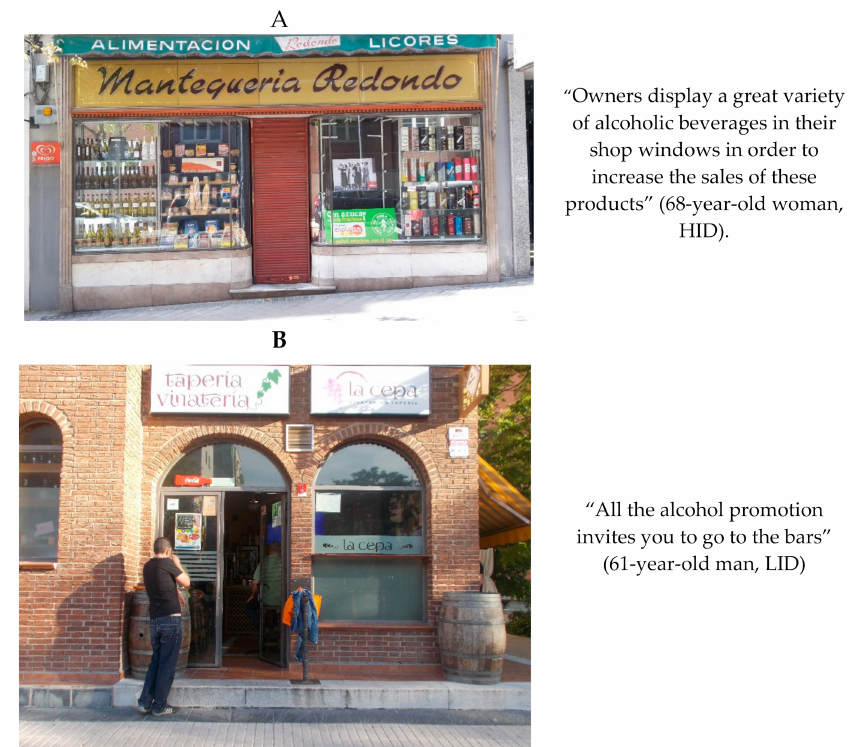
Figure 4. ( A ) Alcohol promotion perceived in high income level neighborhood. Photograph: “Alcohol at first sight”. ( B ) Alcohol promotion perceived in low income level neighborhood. Photograph: “Let´s have the last one”. Examples of the promotion results obtained in the high-income district (HID, Chamber í ) ( A ) and in the low-income district (LID, Villaverde) ( B ) through